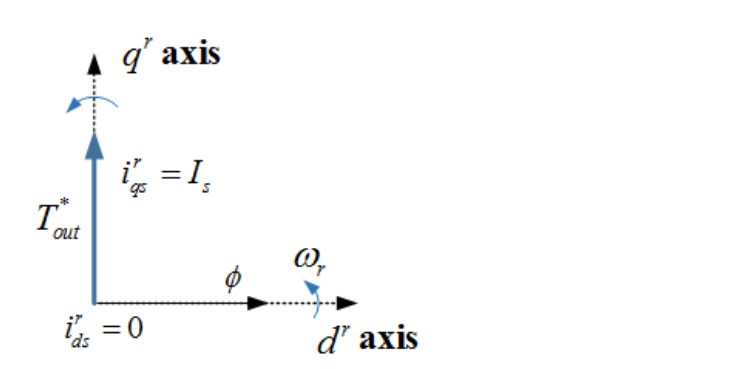
Figure 2. d-q axis current for vector control of SPMSM.